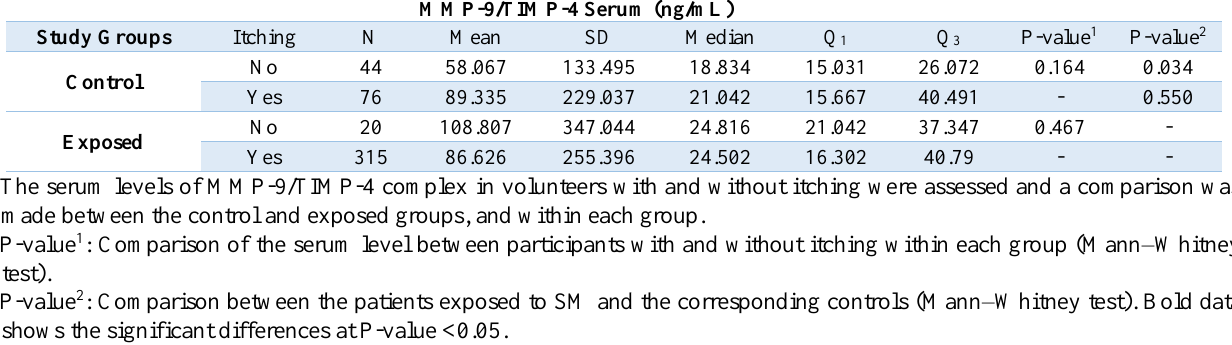
Table 5. sE-Selectin in the Control and Sulfur Mustard Exposed Groups With Itching Study Groups Itching No Control No SM-Exposed Yes 319